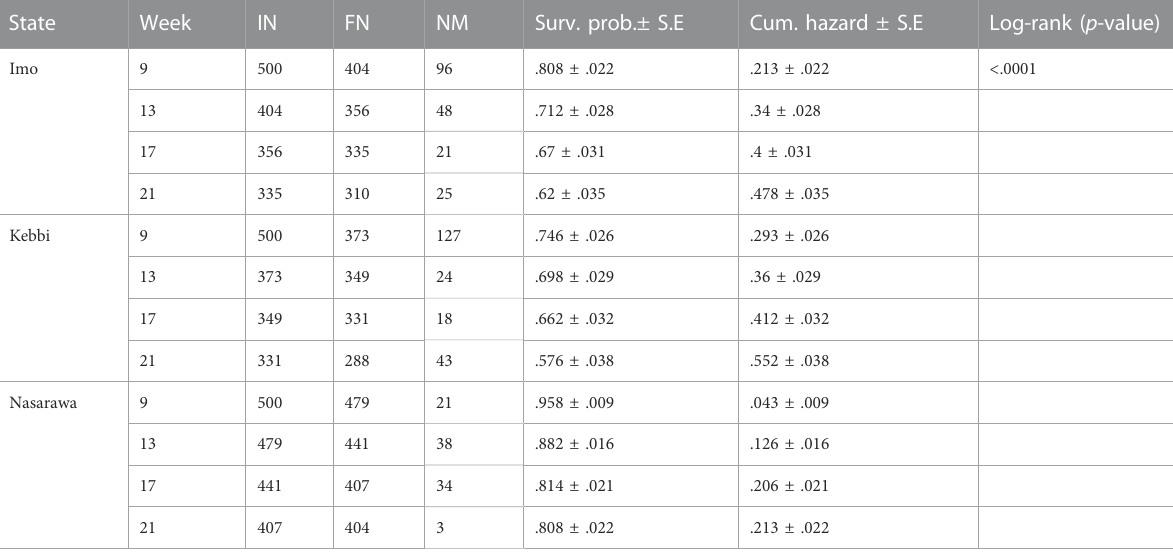
TABLE 5 Effect of agro-ecological zone on survival performance of birds (5 – 21 weeks). State